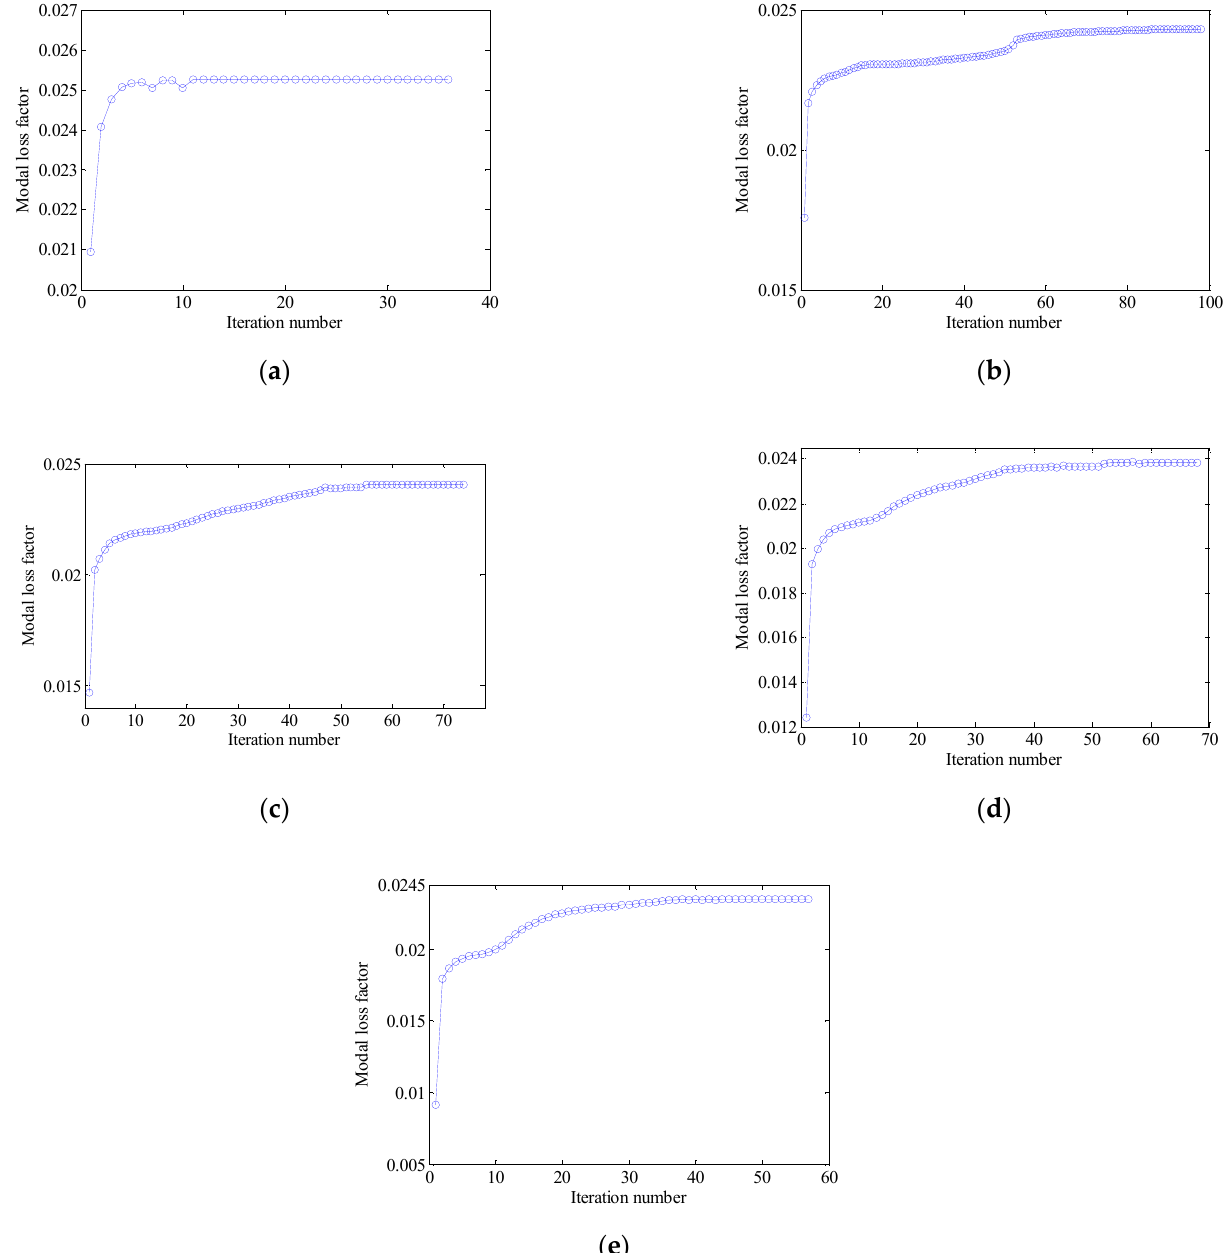
Figure 8. Iteration histories for different penalty factors: ( a ) p = 0; ( b ) p = 1; ( c ) p = 2; ( d ) p = 3; ( e ) p =